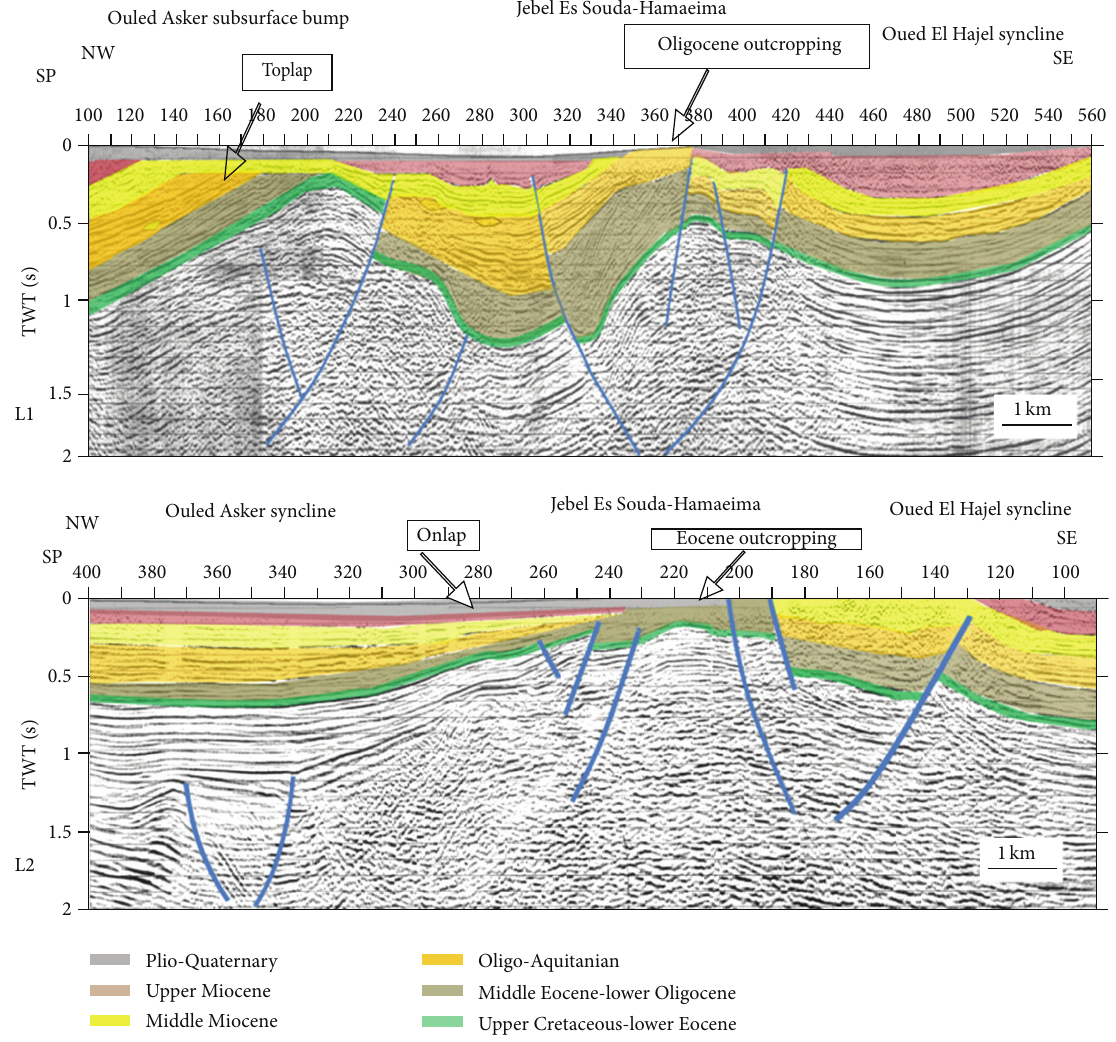
Figure 10: Interpreted seismic lines across the study area (L1 and